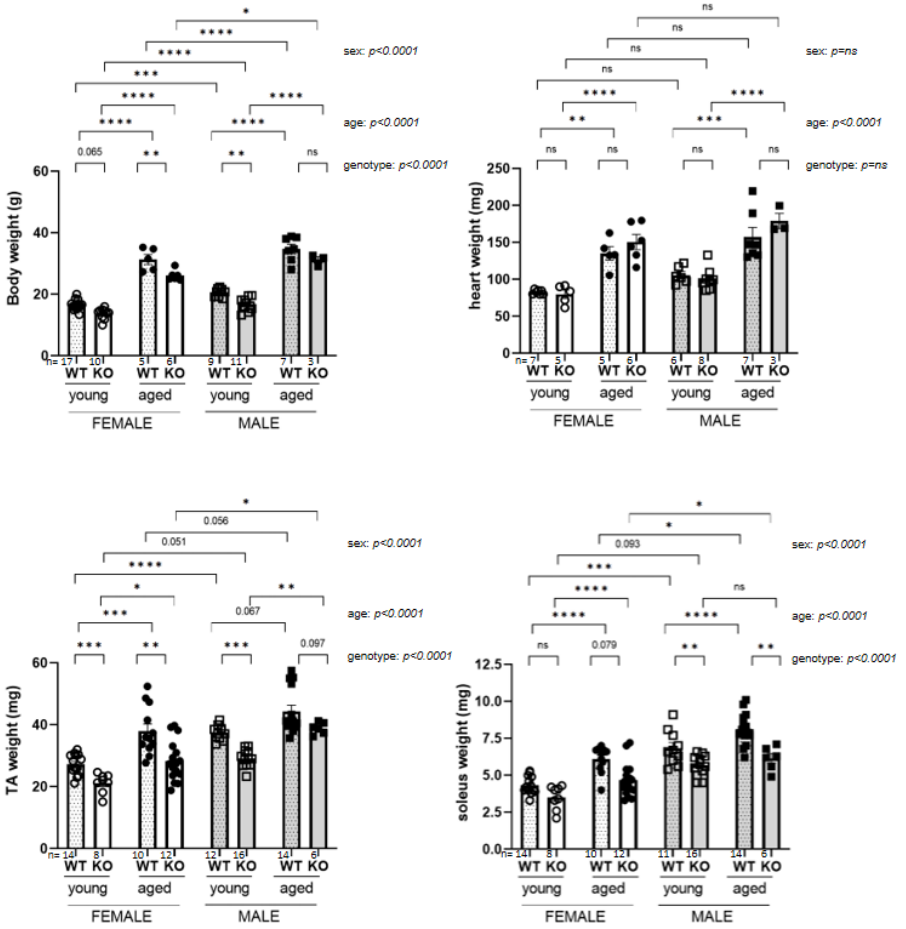
Figure 1. Anatomical parameters of WT and SelenoN KO 1-month (young) and 20-month-old (aged) male and female mice (TA for tibialis anterior). In the graph, p -value are from Tukey’s post hoc tests between pairwise groups. Next to the graph, p -values for sex, age and SelenoN effect are defined in Table 2. * p < 0.05, ** p < 0.01, *** p < 0.001, **** p < 0.0001 and ns not significant. 3.2. Phospholipidomic Analysis Revealed an Important Sex Difference in Diaphragm PL Content